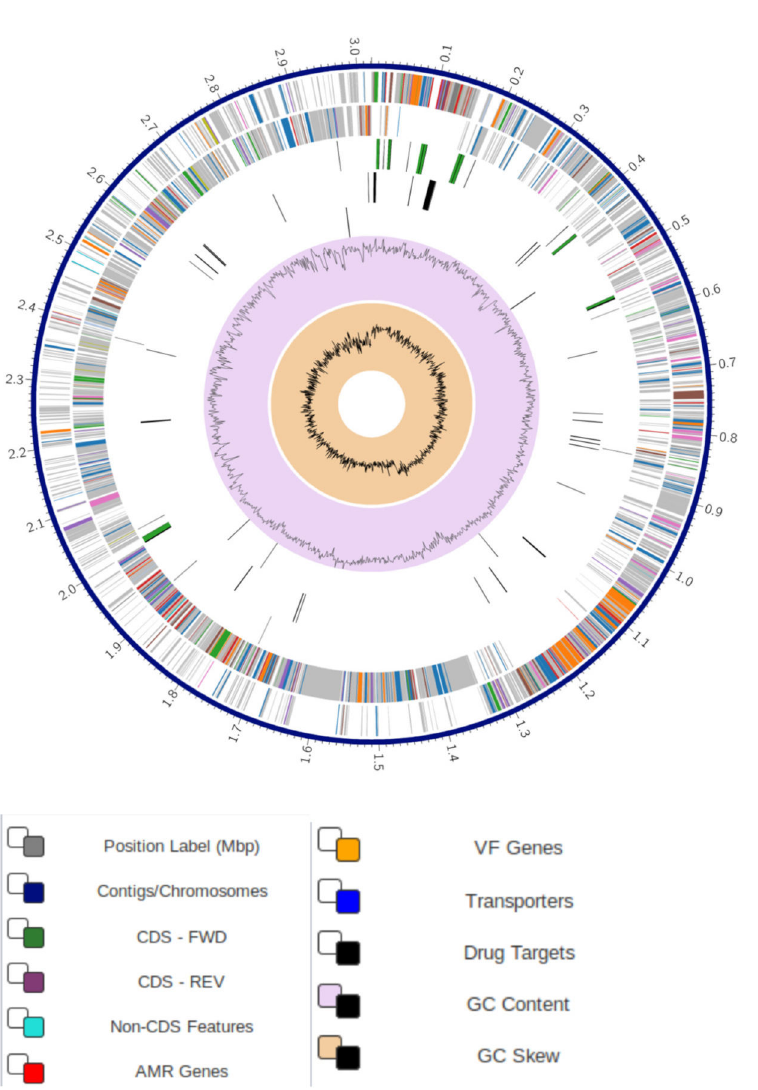
Figure 1. Circular Graphical Assembly of the genome of Bacillus velezensis isolate VB7. Note: The outer to inner rings, the contigs, CDS on the forward strand, CDS on the reverse strand, RNA genes, CDS with homology to known anti-microbial resistance genes, CDS with homology to known virulence factors, GC content, and GC skew. The colors of the CDS on the forward and reverse strand indicate the subsystem that these genes belong to (see Subsystems